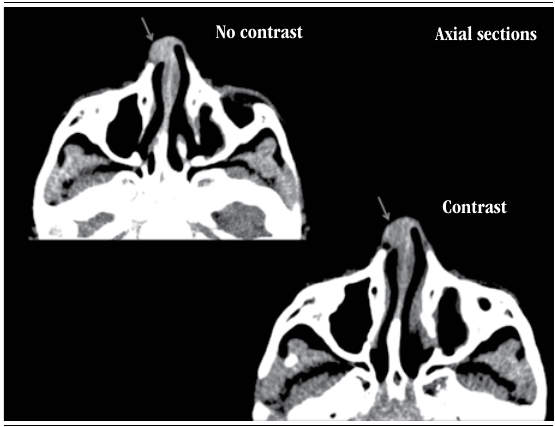
figurE 1 – Post contrast CT image reveals an enhanced lesion in nasal dorsum CT: computed